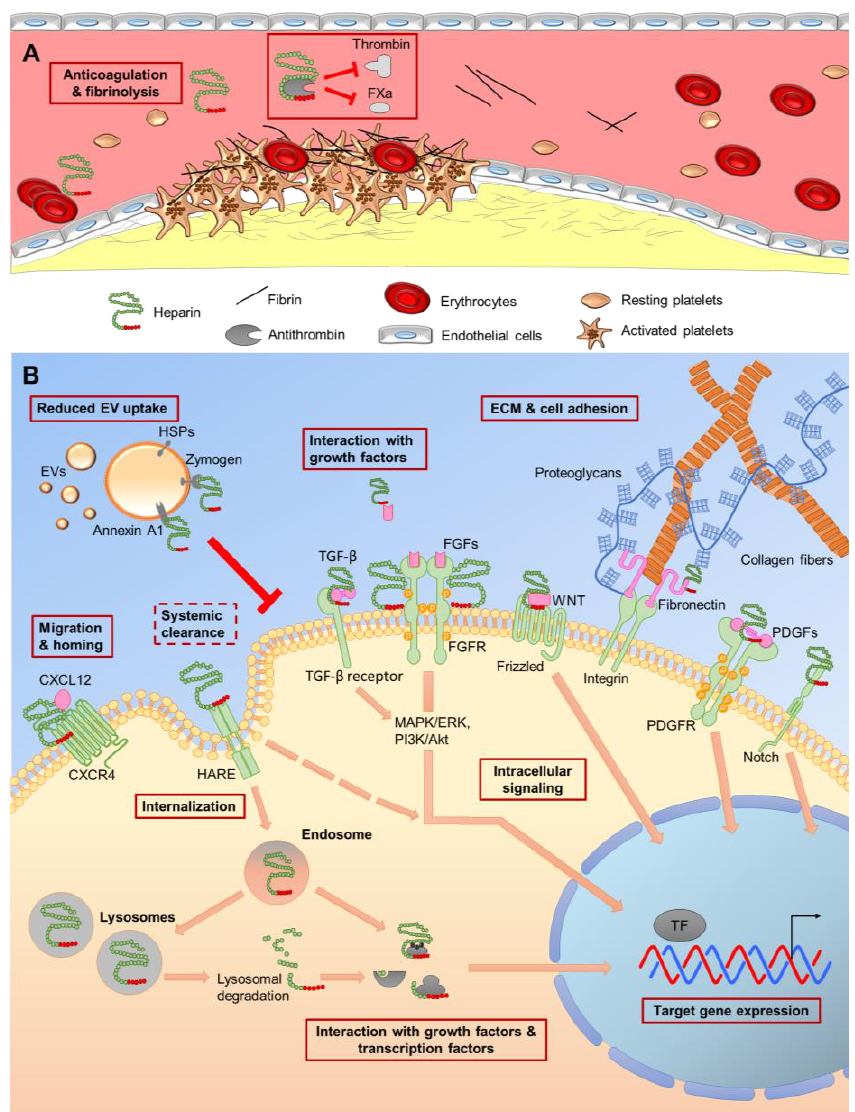
Figure 1. Overview of intravascular, extracellular and intracellular effects of heparin. ( A ) In the blood stream, the anticoagulant effect of heparin results from binding to antithrombin amplifying inhibition of activated factor Xa (FXa) and thrombin. ( B ) In the extracellular and intracellular environment, heparin affects essential cell functions such as ECM formation, cell adhesion and migration. The interaction with the extracellular matrix (ECM), but also growth factor receptors as transforming growth factor (TGF)-beta receptor, fibroblast growth factor receptor (FGFR) Frizzled, Notch and platelet derived growth factor receptor (PDGFR) activates divergent intracellular signaling pathways, putatively affecting gene expression. A systemic clearance of heparin by cellular internalization and lysosomal degradation may finally induce the expression of target genes. Furthermore, the cellular uptake of extracellular vesicles (EVs) can be reduced by heparin, putatively influencing cell-to-cell communication.